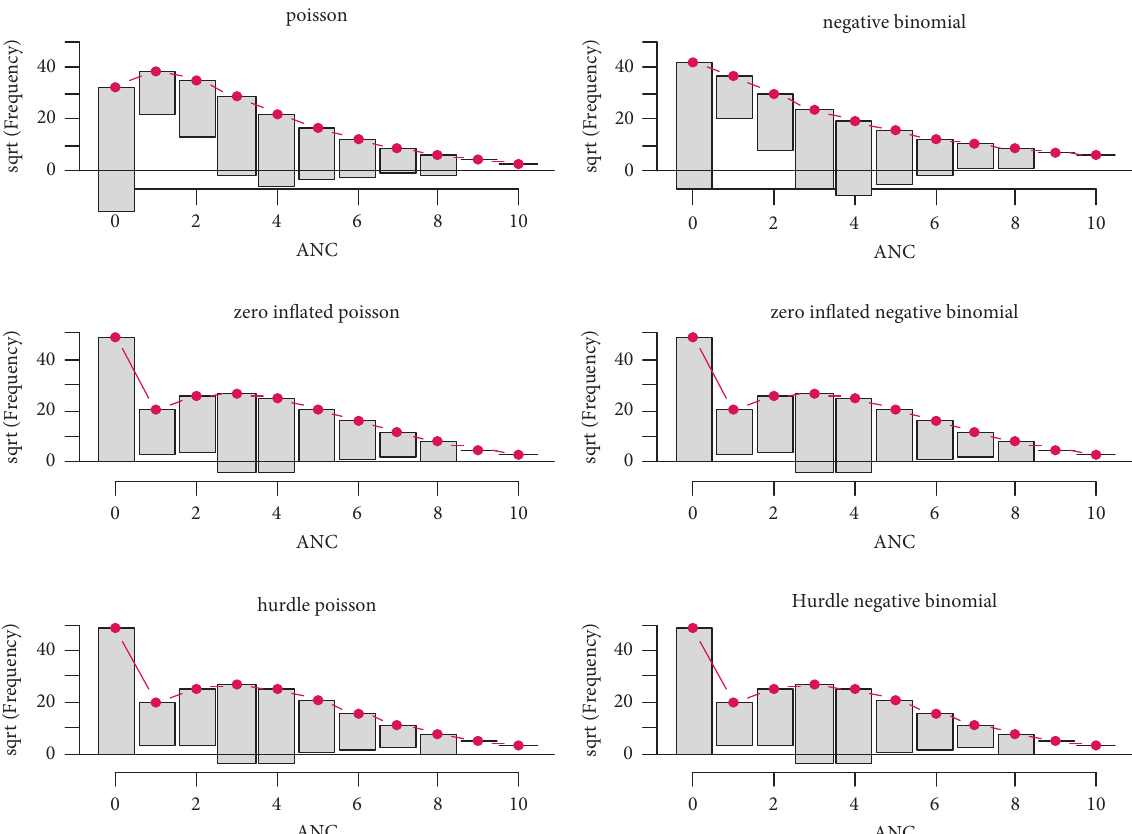
Figure 3: Rootogram to visualize the fit of the hurdle Poisson